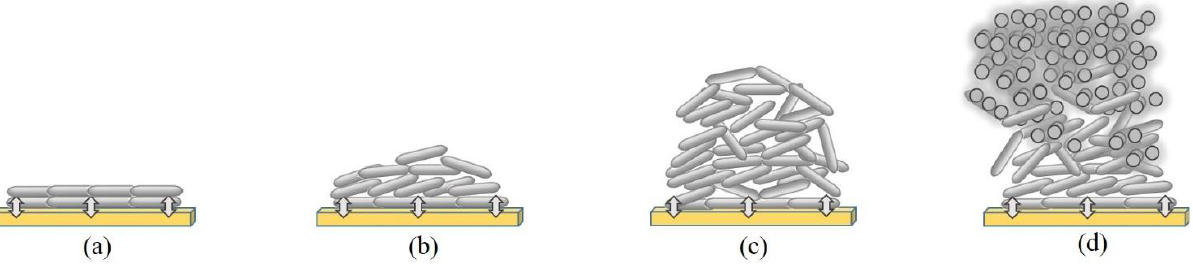
Figure 5. Schematic of the growth process of the deposited Sb 2 Te 3 films with different film thicknesses: ( a ) 0.3, ( b ) 4.5, ( c ) 9.0 and ( d ) 16.7 µm.